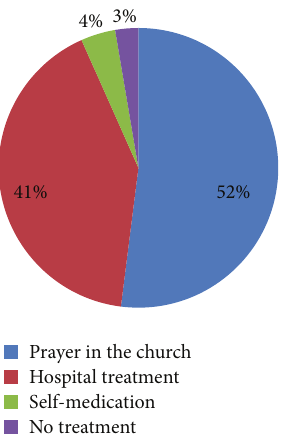
Figure 2: Forms of treatment respondents sought when they were sad or lost interest in routine activities for over one week ( 𝑁 = 75 ).